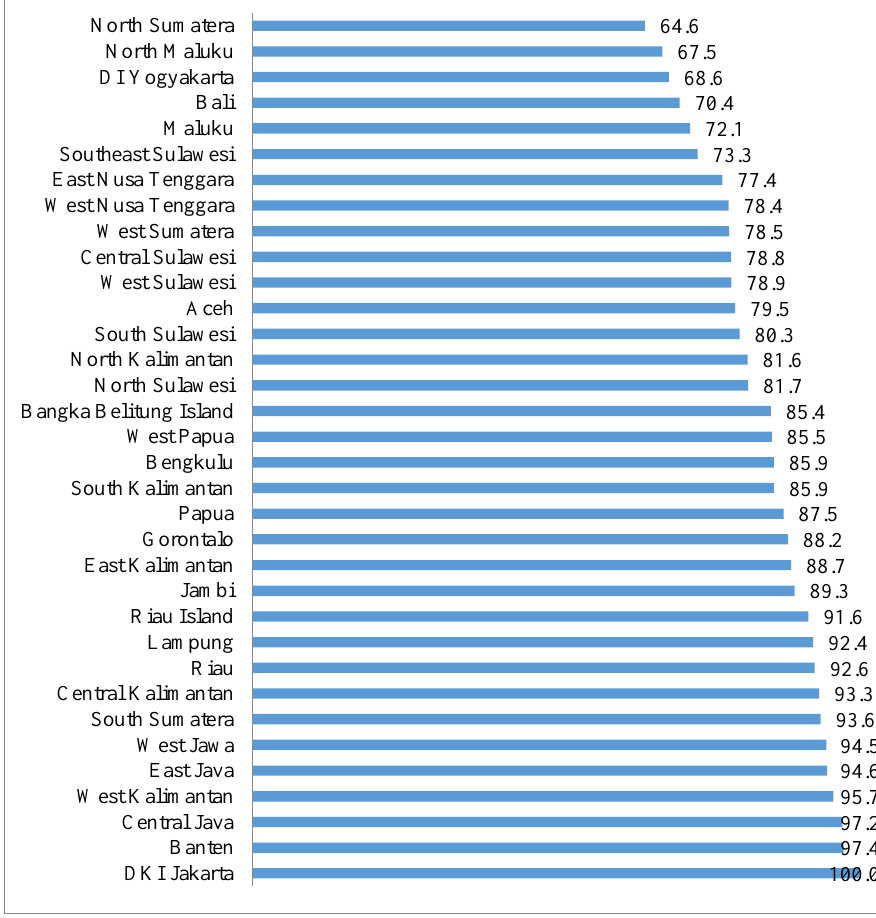
Fig. 1. Percentage of exploited child labour by provinces in Indonesia in 2018. The percentage of exploited child labour in each province is shown in Fig. 1. The provinces with the largest percentage of exploited child labour were DKI Jakarta, then Banten and Central Java. This result is in line with the research of Iryani and Priyarsono (2013) which stated that DKI Jakarta, Banten, and Central Java are the three provinces with the highest level of exploitation severity in terms of working hours [3]. All children who child labour in DKI Jakarta (100 percent) are exploited. This is because the majority of child labour in DKI Jakarta (87.2 percent) work in the formal sector. Workers who work in the formal sector must follow standard working hours like adult workers. This amount has certainly exceeded the limit of working hours allowed for children. The average working hour of child labour in DKI Jakarta is 57.2 hours with a maximum working hour of 84 hours which is not an outlier. In terms of school participation, 67.5 percent of children who child labour in DKI Jakarta are no longer in school. Besides that, the entire DKI Jakarta area is an urban area that is also the center of Indonesia's economy. All of these are great potentials for the exploitation of child labour in DKI Jakarta